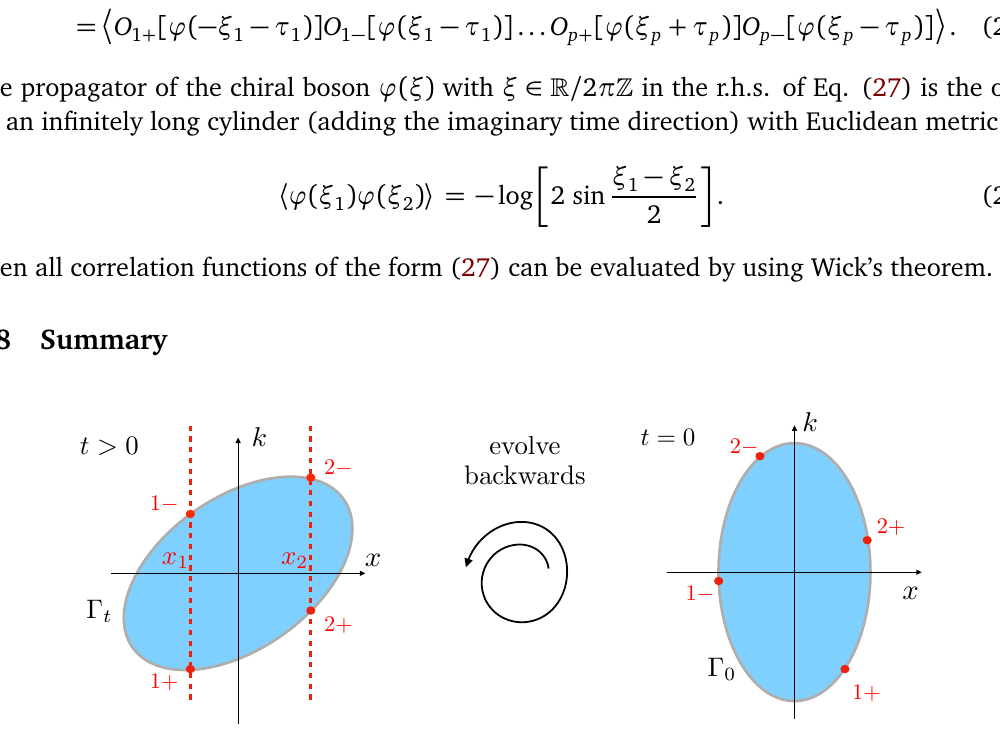
Figure 3: Summary of the approach taken in this paper. To calculate the correlation ( x ( x function 〈 O , t ) O , t ) 〉 at time t , we start by writing it in terms of chiral oper- 1 1 2 2 〉 that generate low-energy excitations around the Fermi points O O O ators 〈 O 1 + 1 − 2 + 2 − ( x ( x ( x ( x ( x , k , t )) , ( x , k , t )) , ( x , k , t )) , ( x , k , t )) . Then we trace F − F + F − F + 1 1 1 1 2 2 2 2